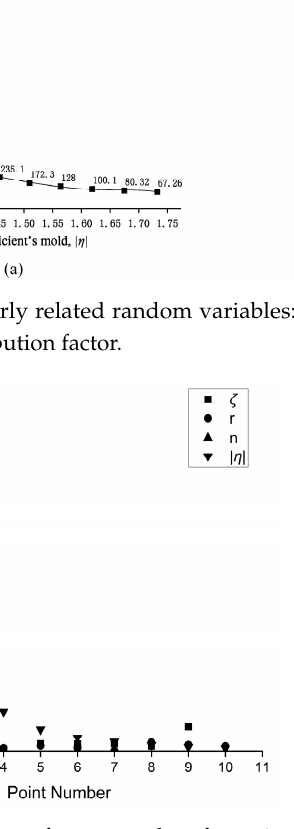
Figure 13. r_range value of every random factor in each data point.